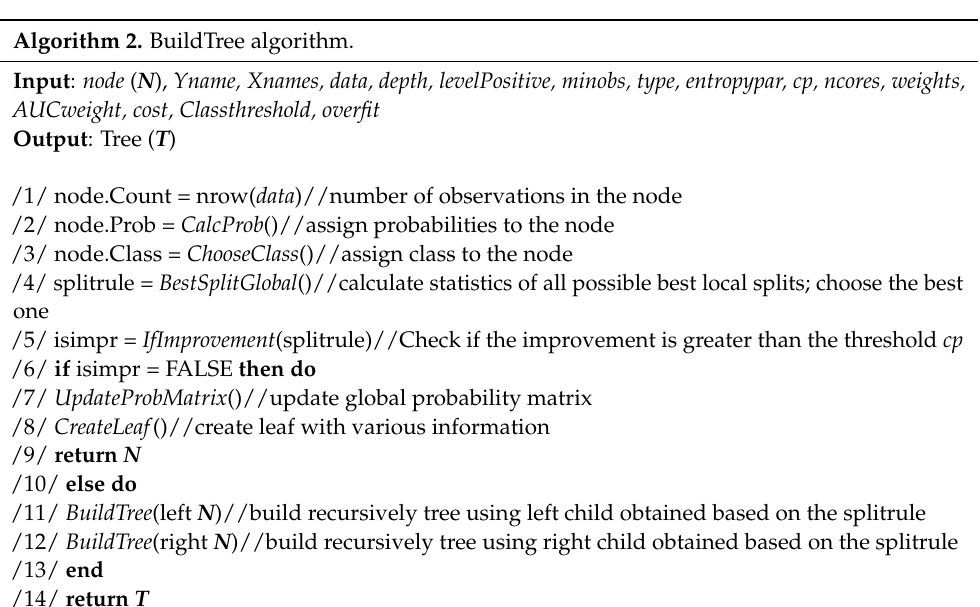
Algorithm 2. BuildTree